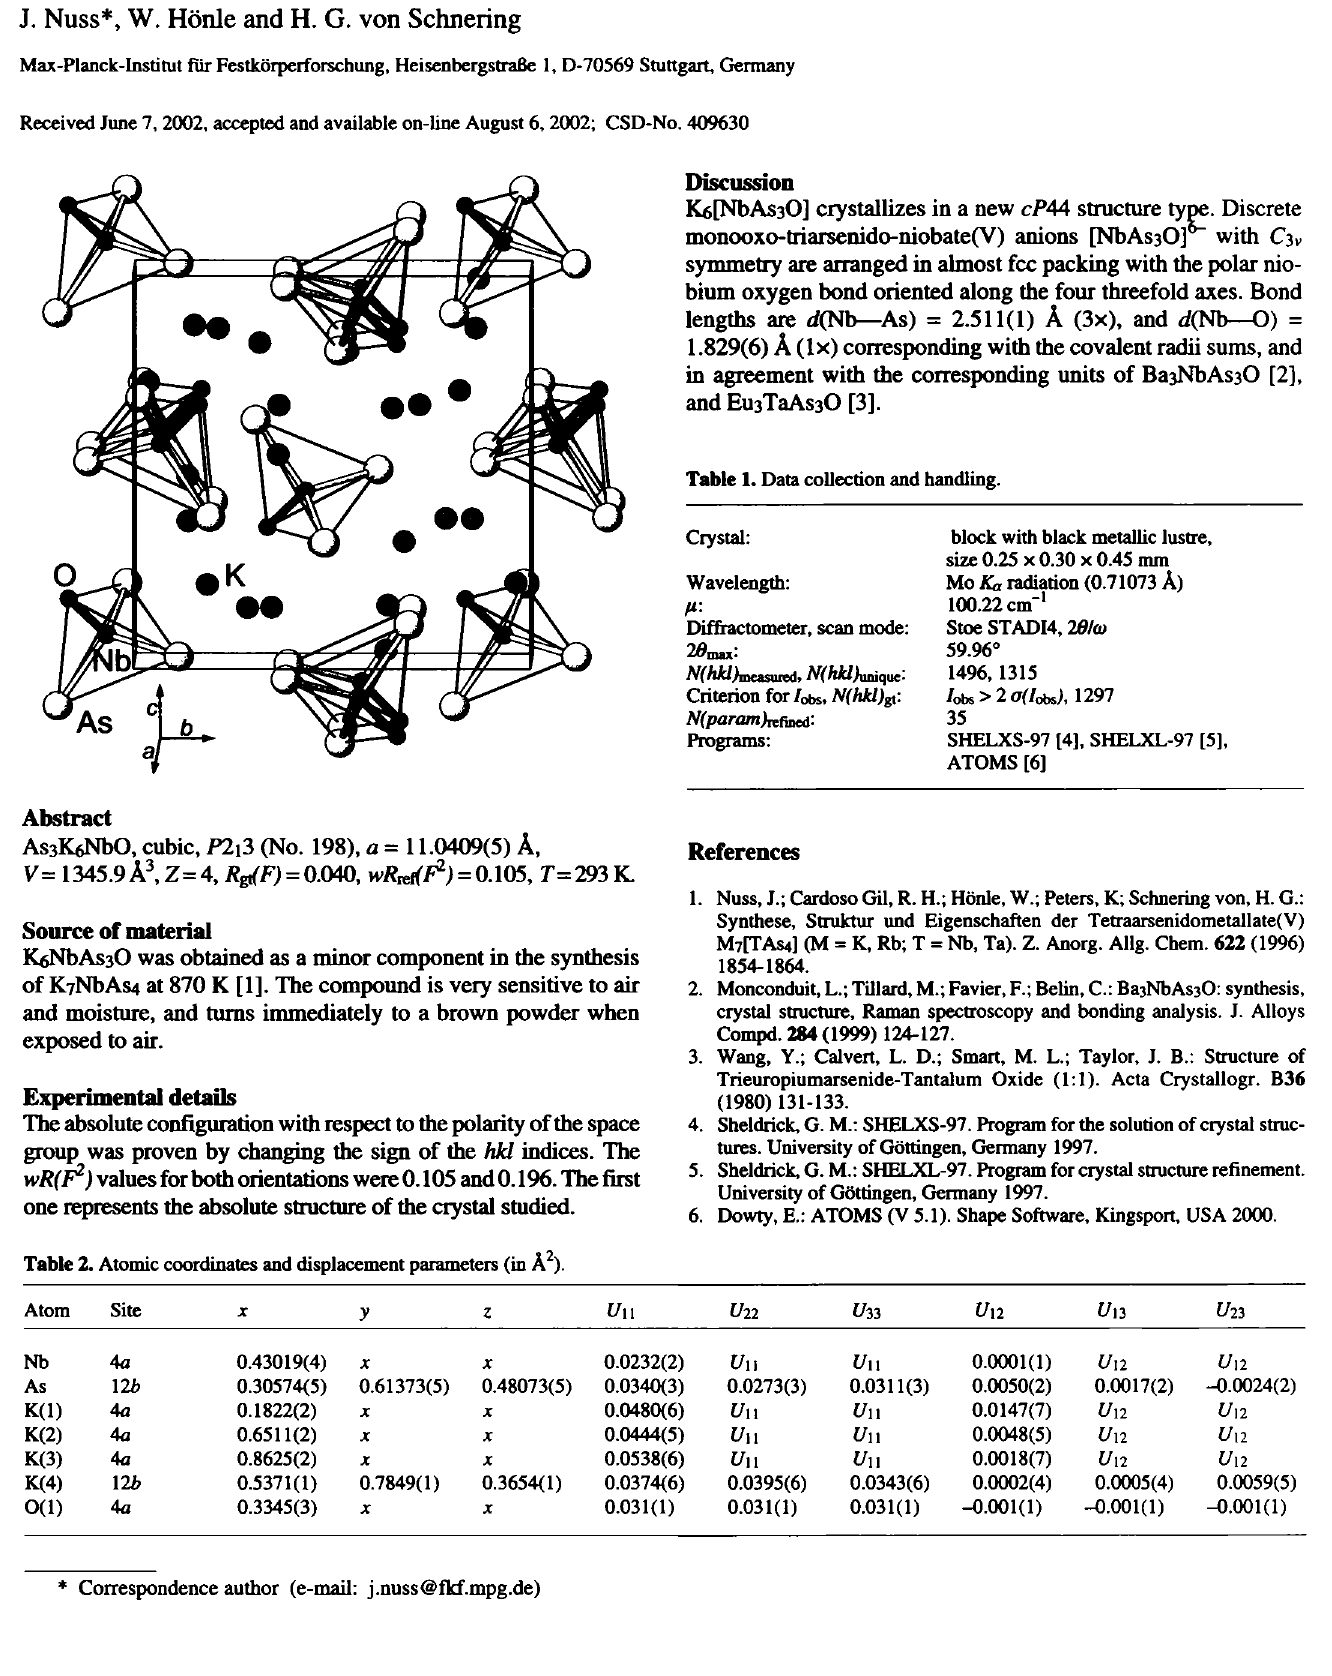
Table 2. Atomic coordinates and displacement parameters (in Â 2